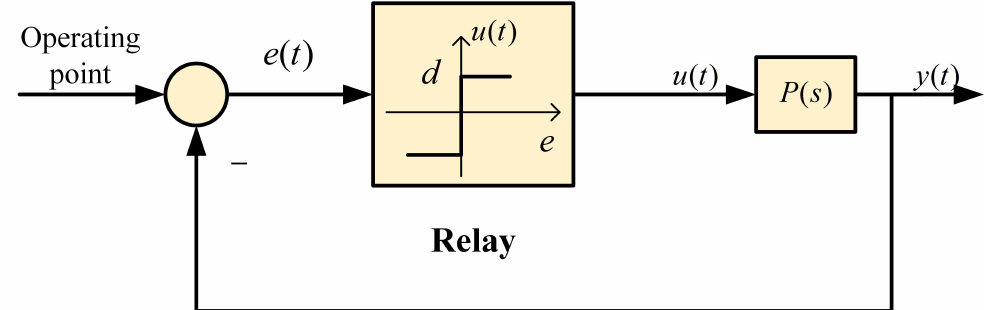
Figure 4. Schematic representation of the relay